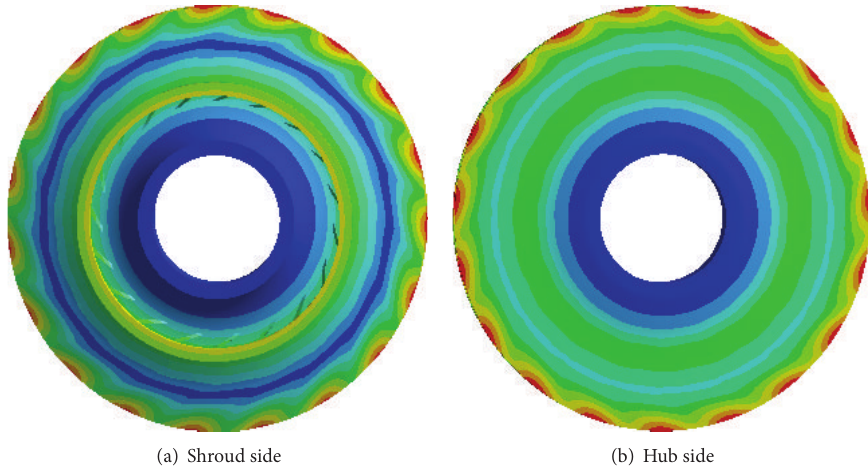
Figure 18: The 17th mode of